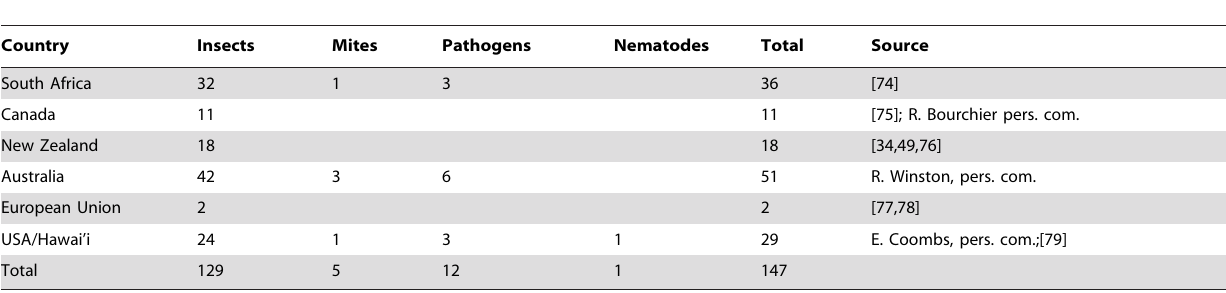
Table 1. Updated list of classical biological control agents released against weeds, since Julien and Griffiths [35].